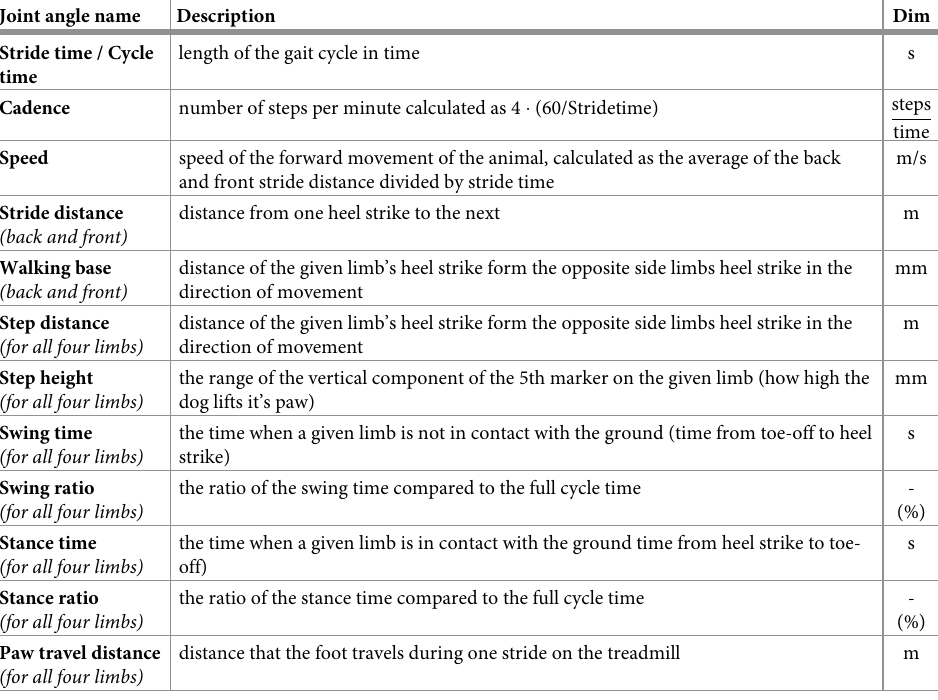
Table 3. Spatio-temporal